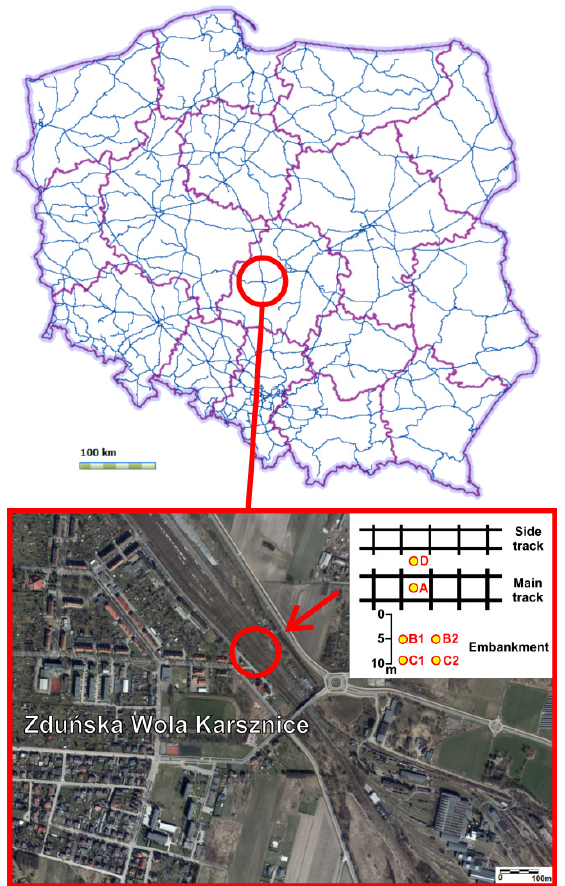
Figure 1. Railway network on the administrative division of Poland [34] with the location of the study area [35] with schematic sampling arrangement.